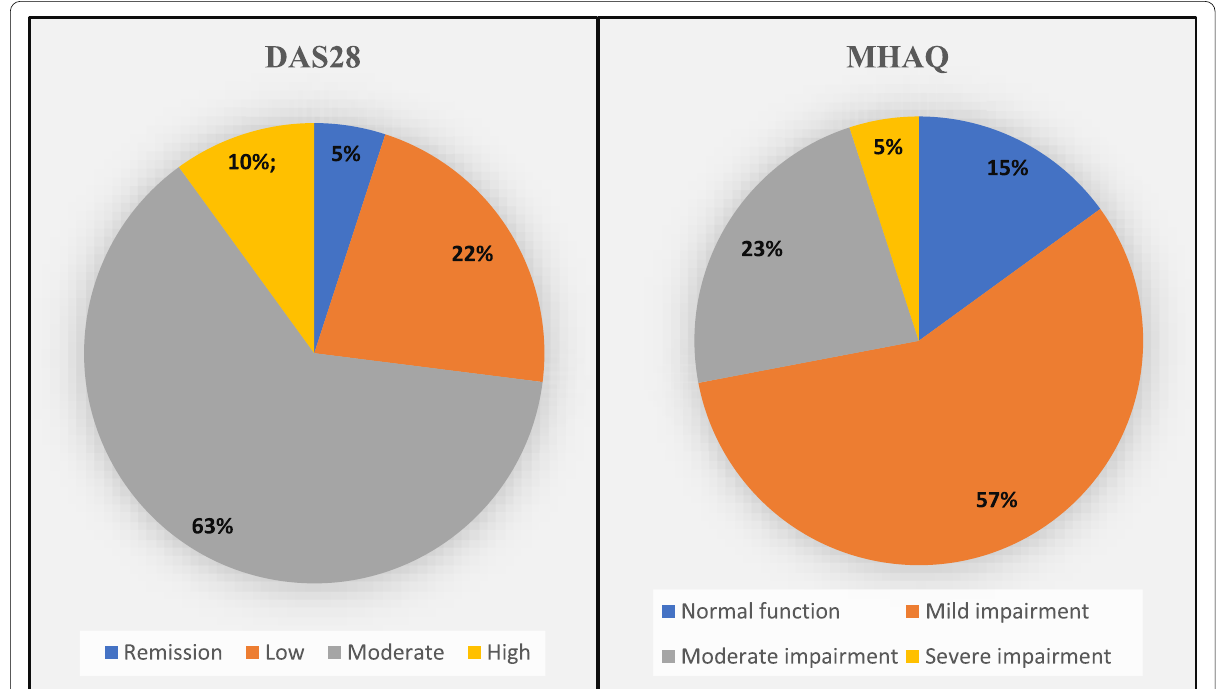
Fig. 1 Clinical characteristics of patients with